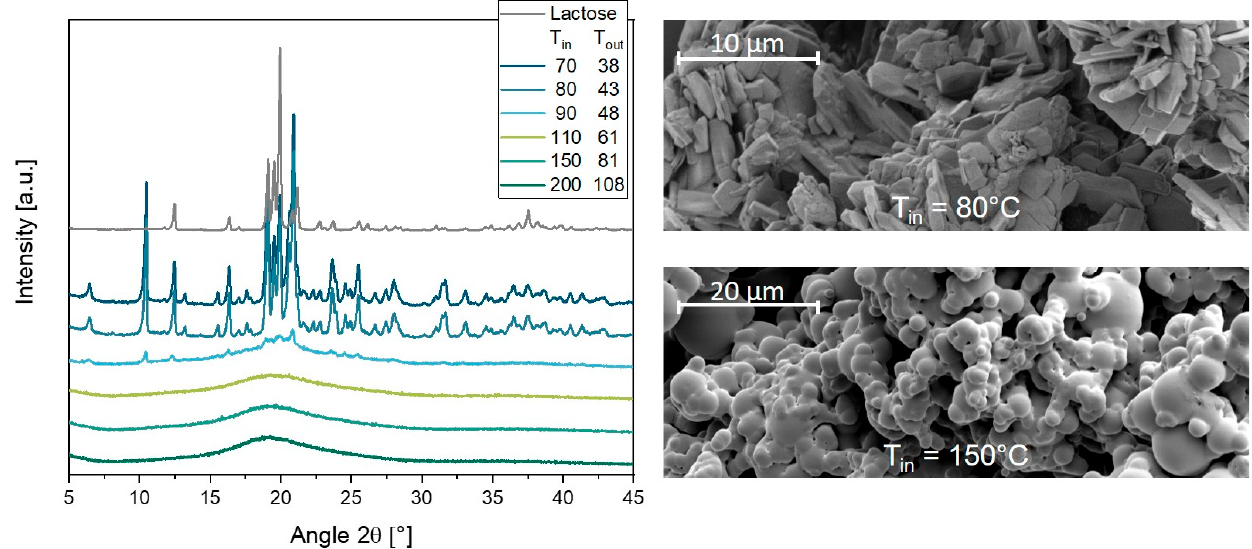
Figure 8. X-ray diffractograms of lactose starting material and trimyristin suspensions spray-dried at T in between 70 °C and 200 °C ( left ); SEM images of lipid-containing powders dried at T in = 80 °C ( right , top ) and T in = 150 °C ( right , bottom ).